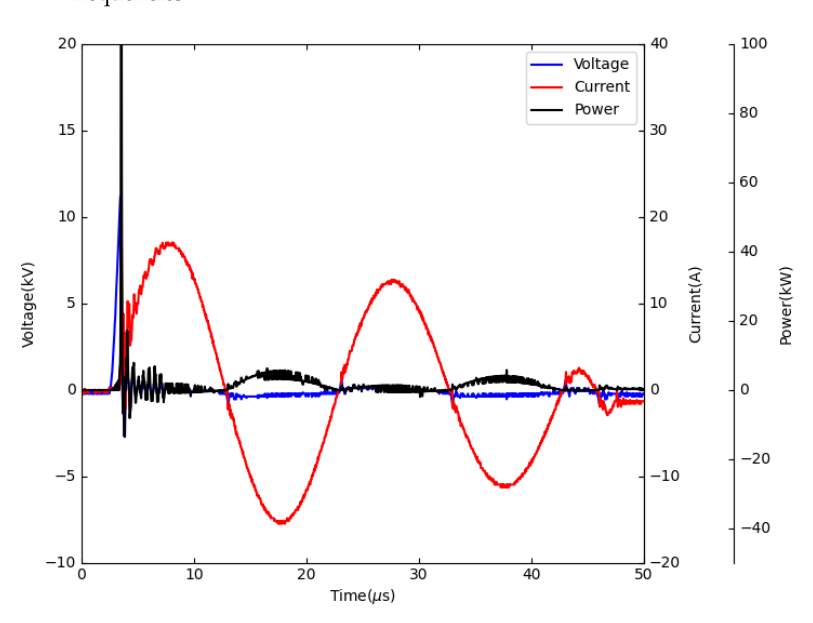
Figure 4. Discharge